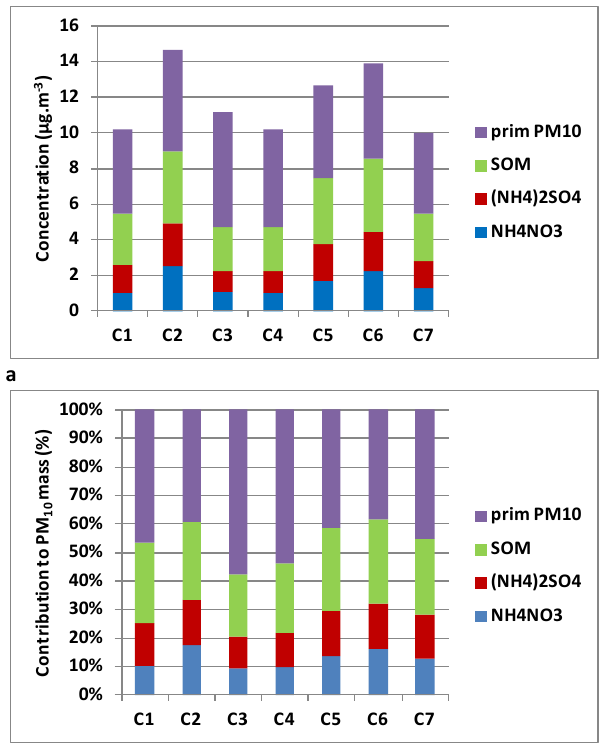
Fig. 8. Composition of PM using the pragmatic mass closure model as a function of back trajectory clusters (a) absolute values in µgm − 3 and (b) % of PM 10 mass. SOM is secondary organic matter.